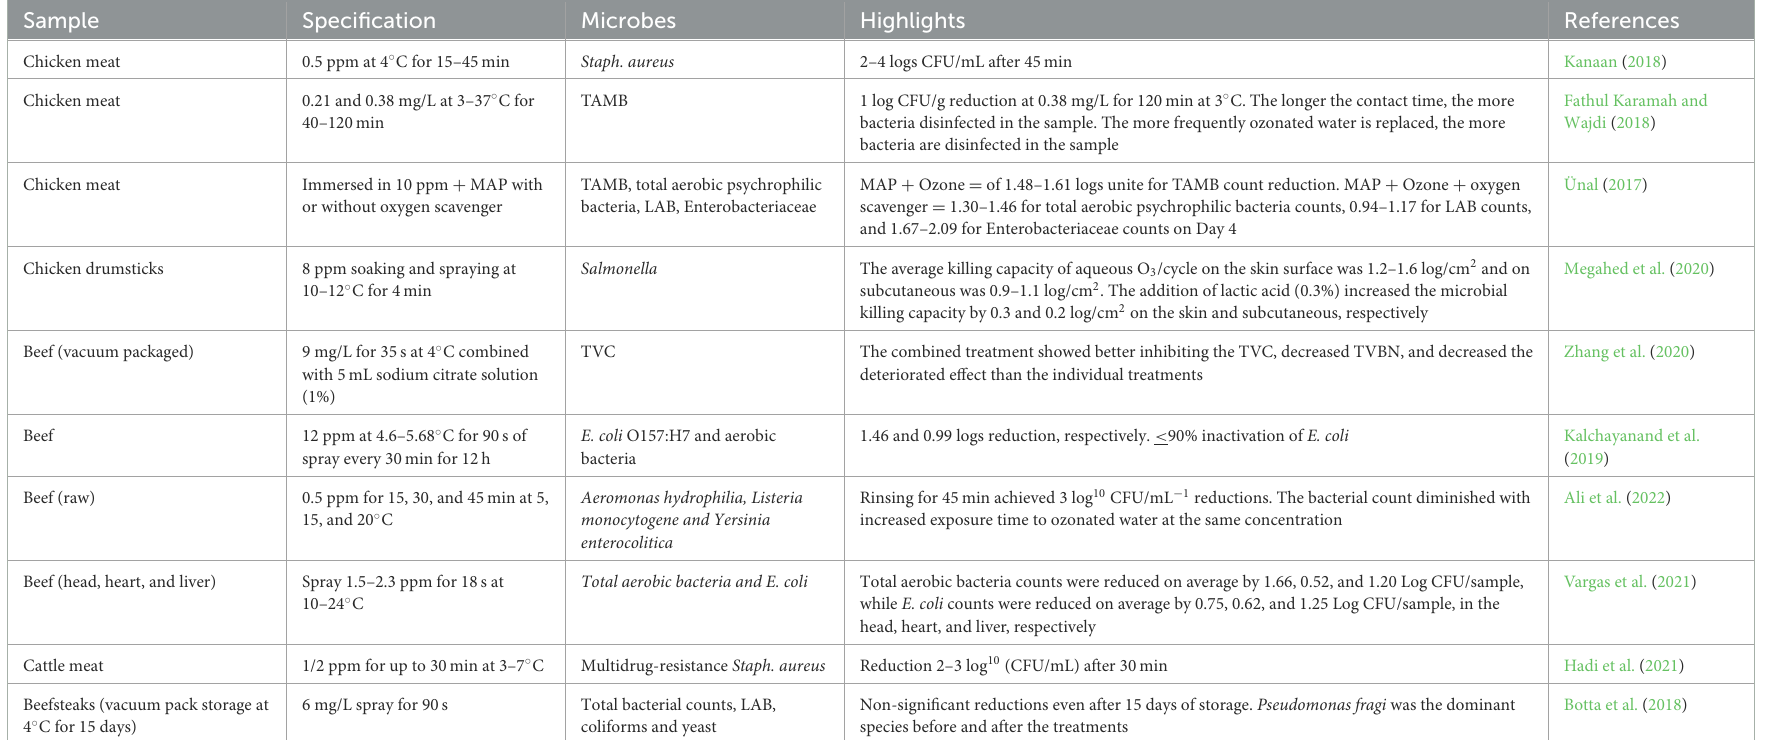
TABLE 1 A summary of studies reporting the decontamination of meat using ozonated